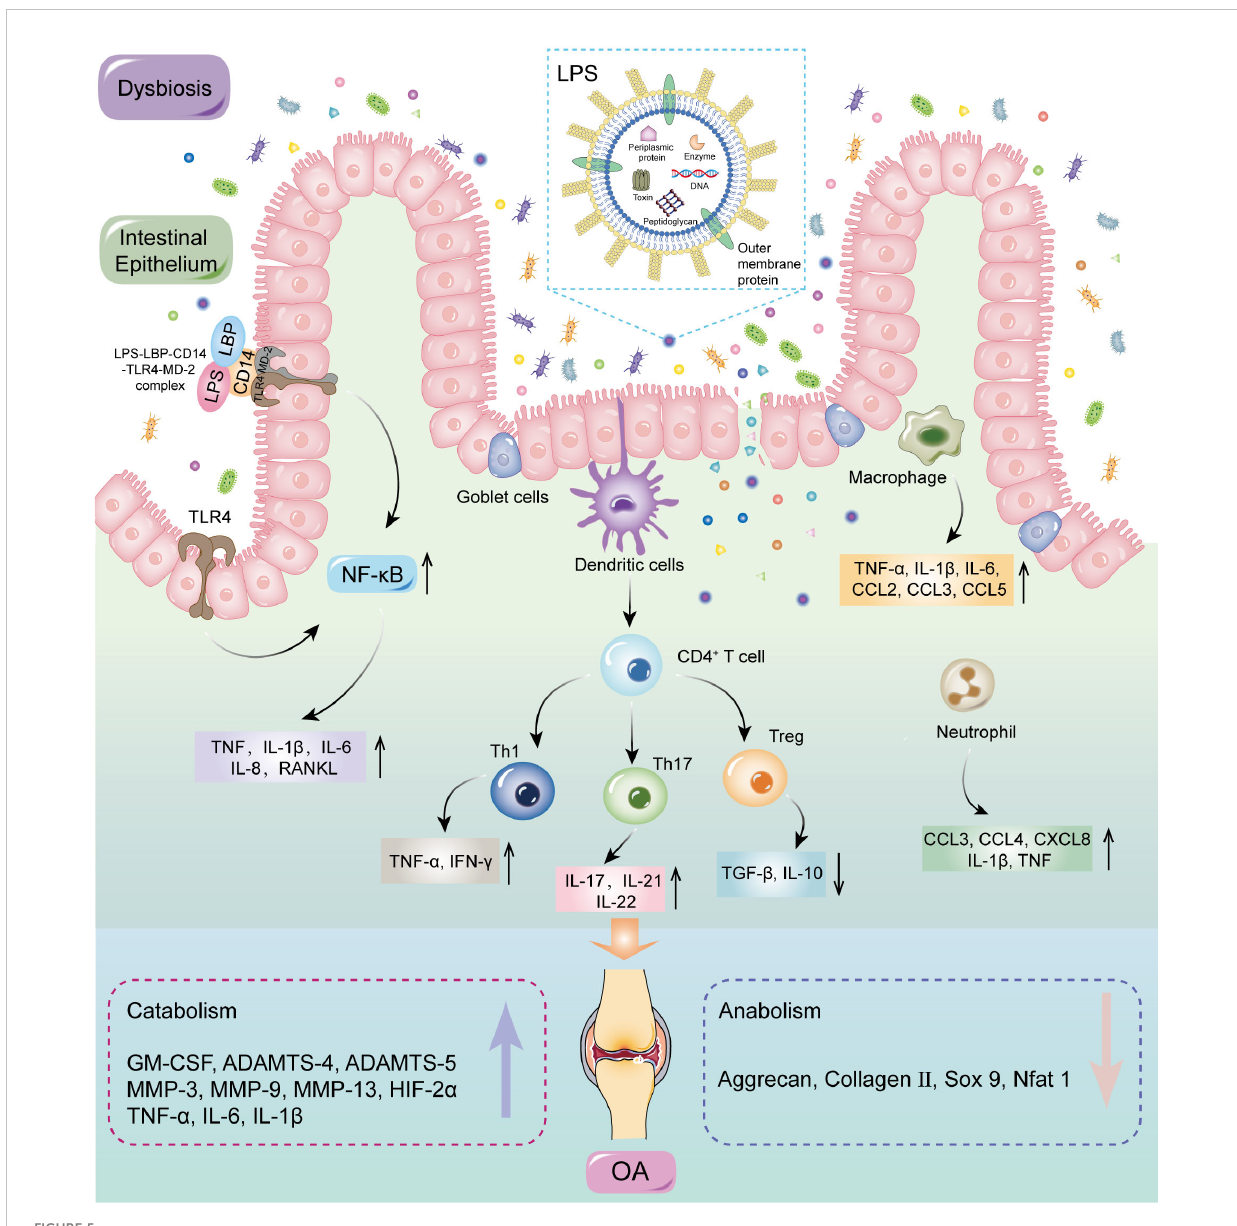
FIGURE 5 MAMPs may induce in fl ammation by activating the immune system. GMB dysbiosis can disrupt the structure and function of intestinal barrier, therefore allowing MAMPs to enter the submucosa. MAMPs could directly interact with various immune cells, including neutrophils, macrophages, and dendritic cells. Dendritic cells can induce the initiation and differentiation of naive CD4 + T cells into effector cells. Activation of the in fl ammatory response can promote catabolism, reduce anabolism, and enhance NF- k B activation, culminating in secondary in fl ammation of the joints. LPS, lipopolysaccharide; LBP, LPS binding protein; CD 14, cluster of differentiation 14; TLRs, Toll-like receptors; MD-2, Myeloid differentiation protein-2; MAMPs, microbial-associated molecular patterns; NF- k B, nuclear factor kappa-B; TNF, tumor necrosis factor; IL, interleukin; CCL, CC-chemokine ligand; IFN, interferon; CXCL, CXC-chemokine ligand; GM-CSF, granulocyte – macrophage colony-stimulating factor; TGF, transforming growth factor; Th, T helper; Treg, regulatory T; MMP, matrix metallopeptidase; HIF, hypoxia inducible factor; SOX 9, SRY-Box transcription factor 9; Nfat, nuclear factor of activated T